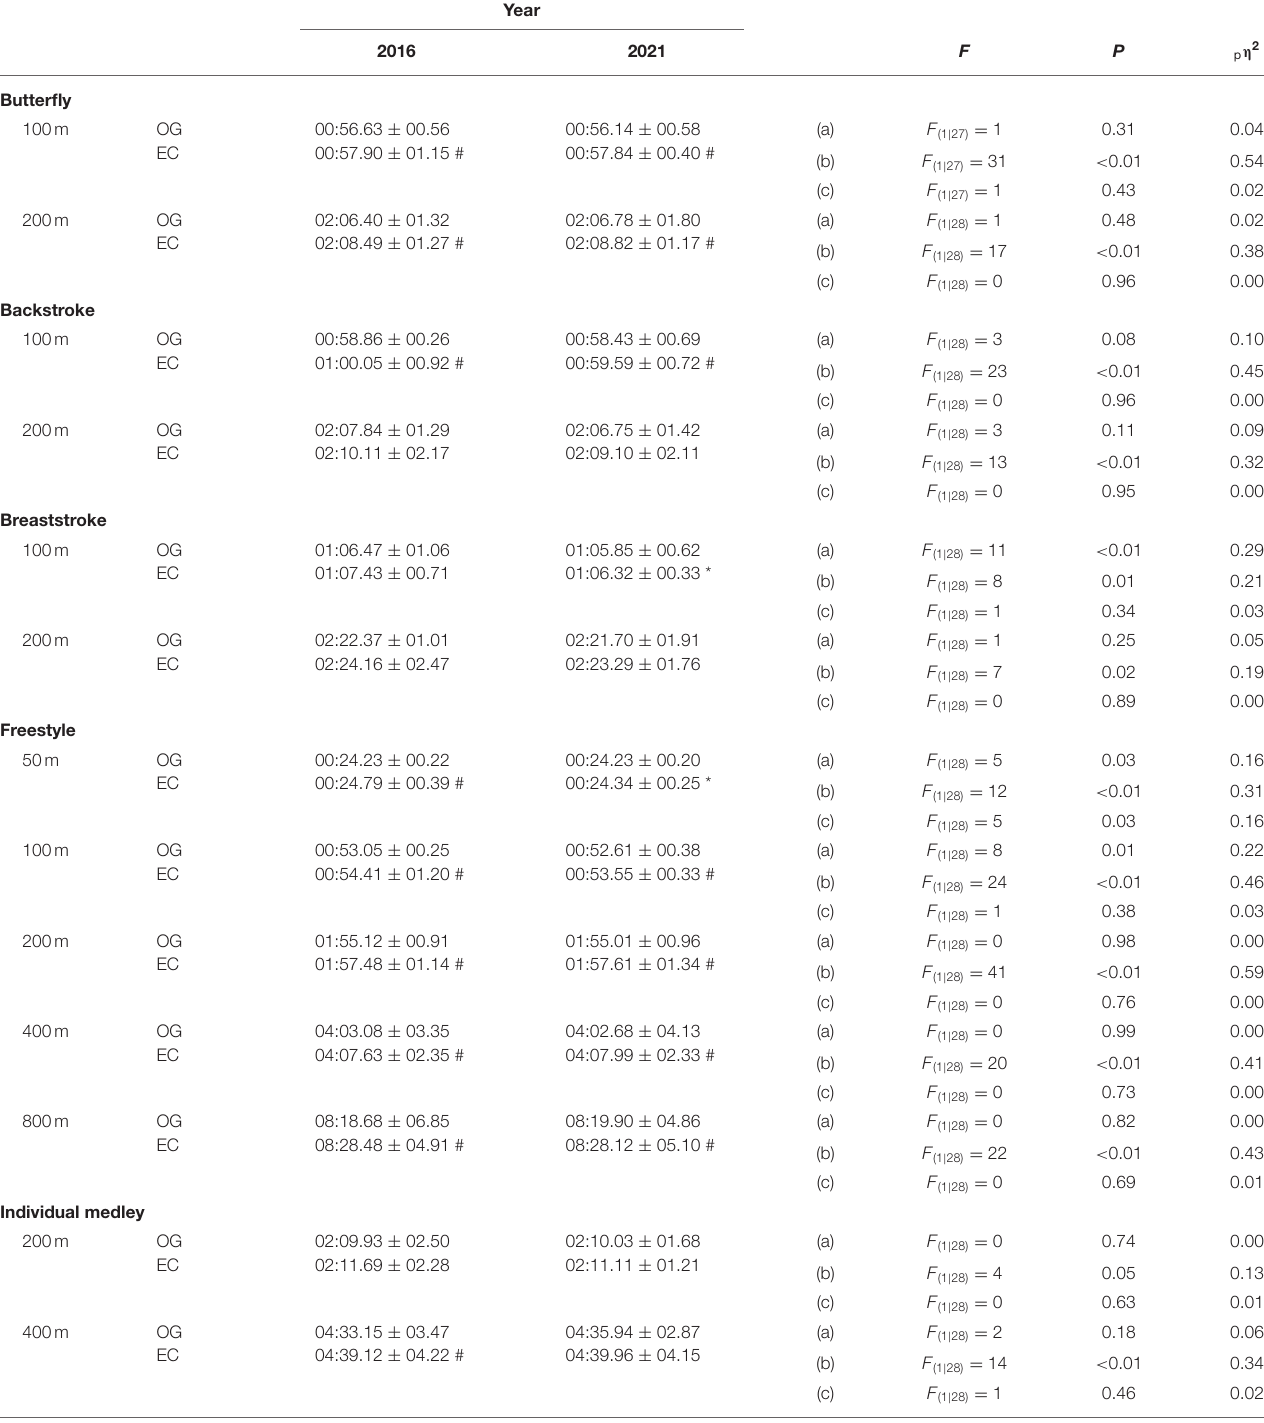
TABLE 3 | Development of race times in female finalists at the Olympic Games (OG) and European championships (EC) across the 5-year Olympic